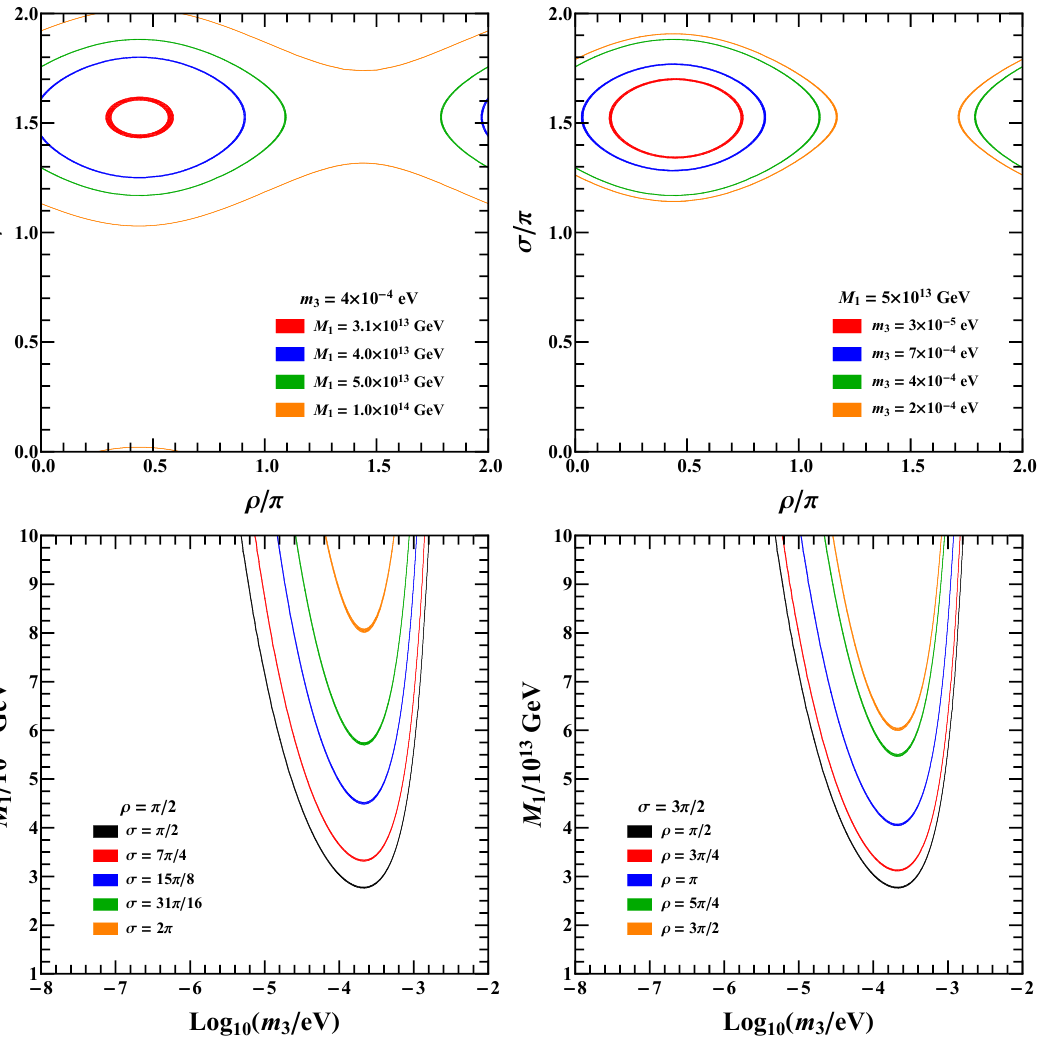
Figure 3 . A viable un(cid:13)avored leptogenesis scenario in the inverted neutrino mass ordering case: the parameter space of (cid:26) and (cid:27) (upper panels) with some given values of m parameter space of m and M (lower panels) with some given values of (cid:26) and (cid:27) . 1 1 one can also see from the lower panels of (cid:12)gure 3. We (cid:12)nd that m